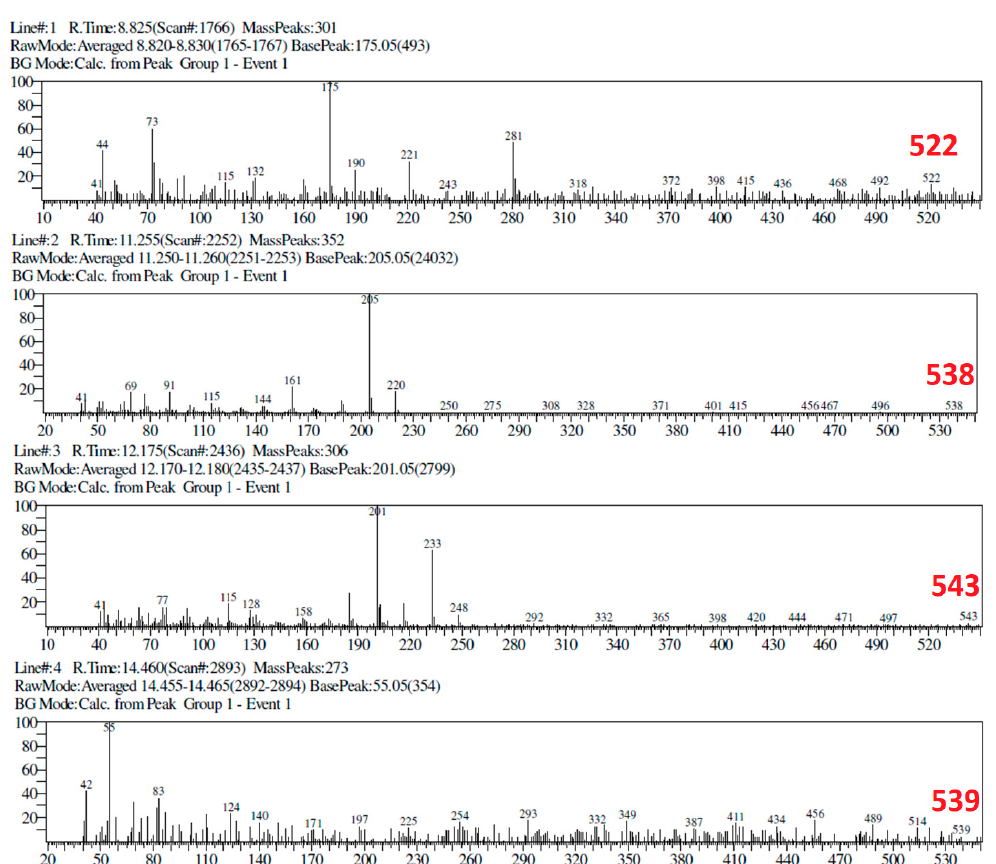
Figure 9. The mass spectra of four peaks identified from GC chromatogram of Ageratum fraction 2. According to Figure 8, four peaks with R t 8.825 min, 11.255 min, 12.175 min, and 14.460 min are